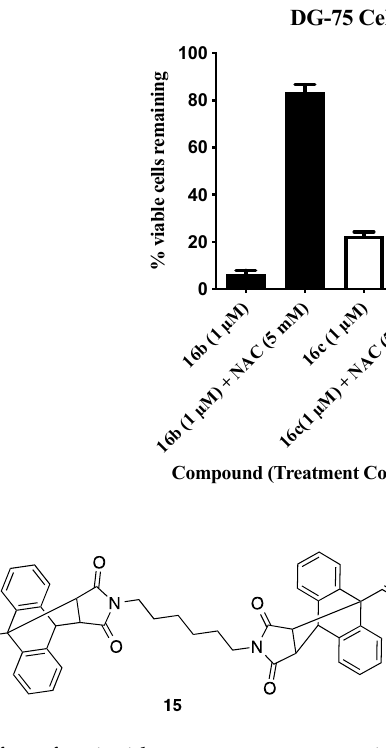
Figure 8. Effect of antioxidant pre-treatment on viability of DG-75 cells treated with compounds 15 , 16b and 16c .